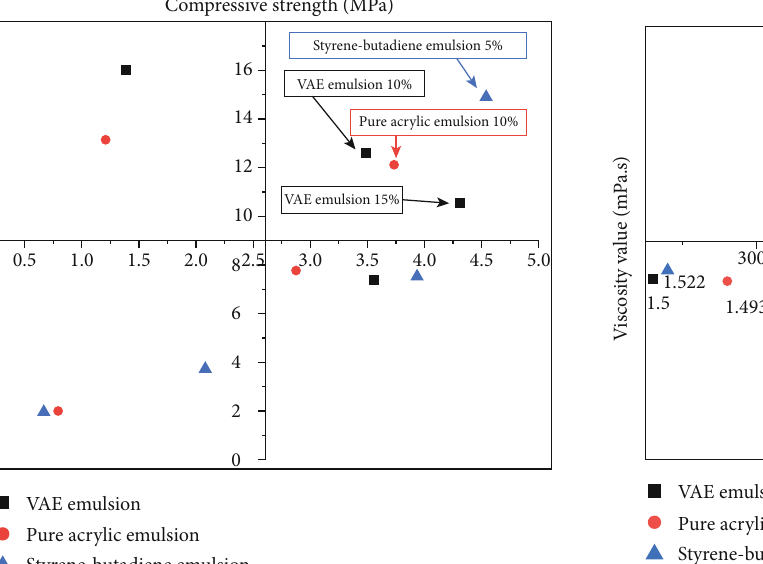
Figure 15: Scatter distribution of viscosity and drawing